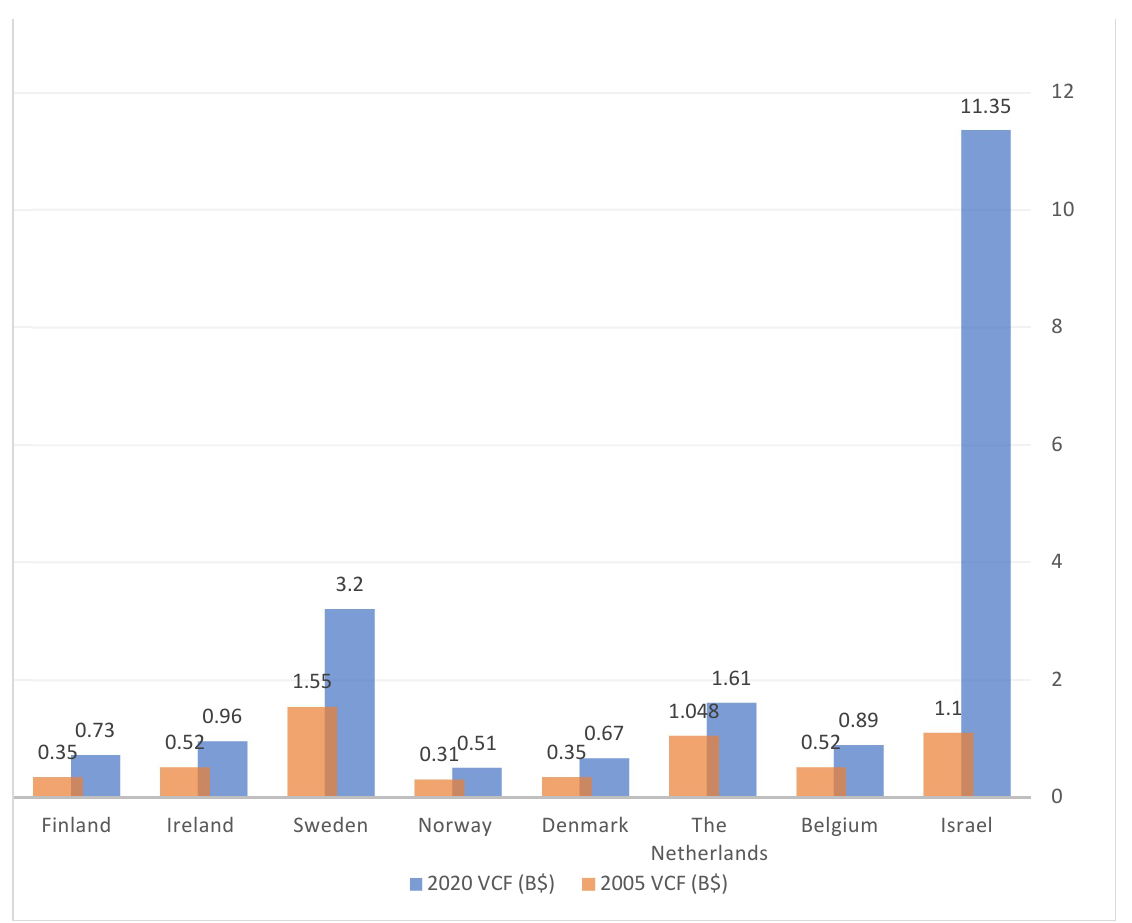
Figure 3. Small developed countries’ VCF in 2020 vs. 2005, in $US billions. Source: authors’ analysis of European Commission data on venture capital 2006 and 2021 reports.